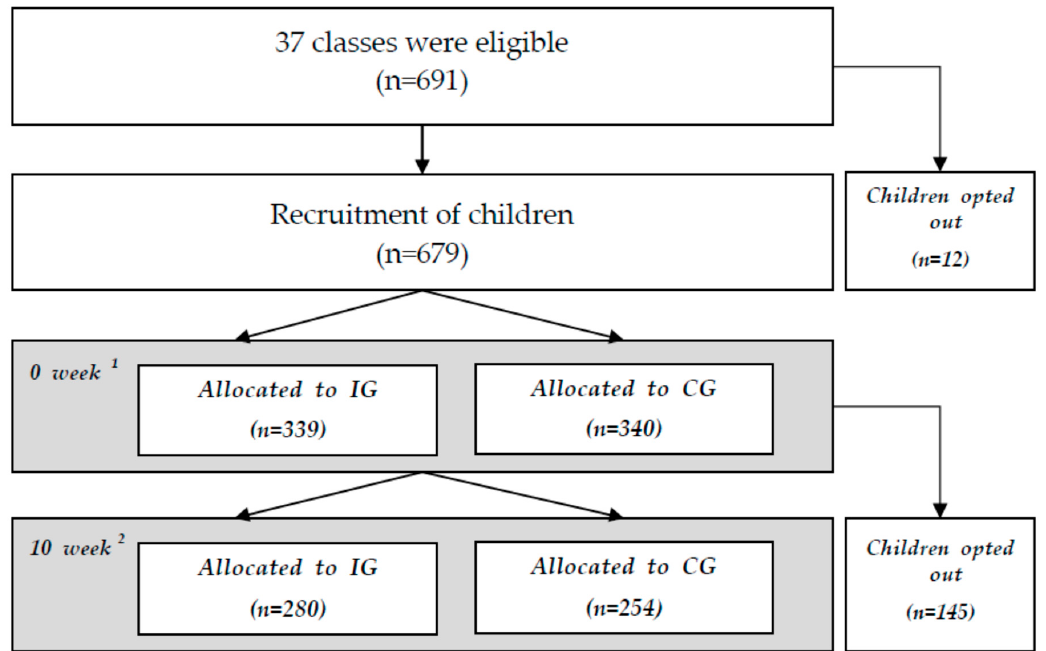
Figure 1. Intervention procedures following as the study protocol. 1 0 week (baseline): anthropometric measurement (n = 679), self-reported demographic and NQ questionnaires (n = 534), 2 10 week (follow-